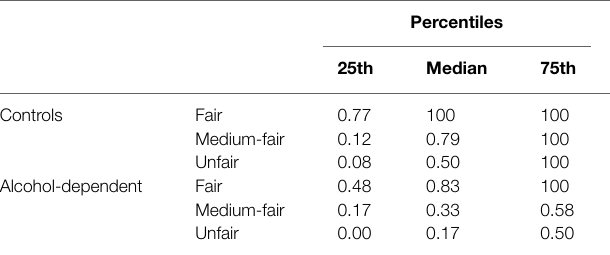
TABLE 2 | Descriptive statistics of the proportion of offers accepted for alcohol-dependent and control participants with unfair, medium fair, and fair